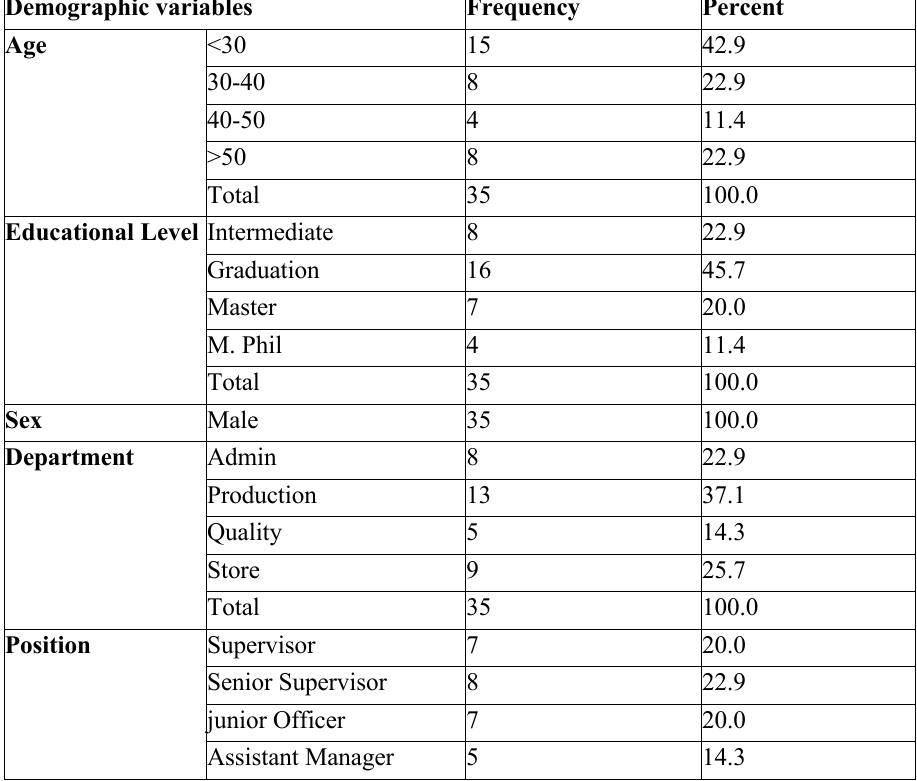
Table 1: Description of Demographic